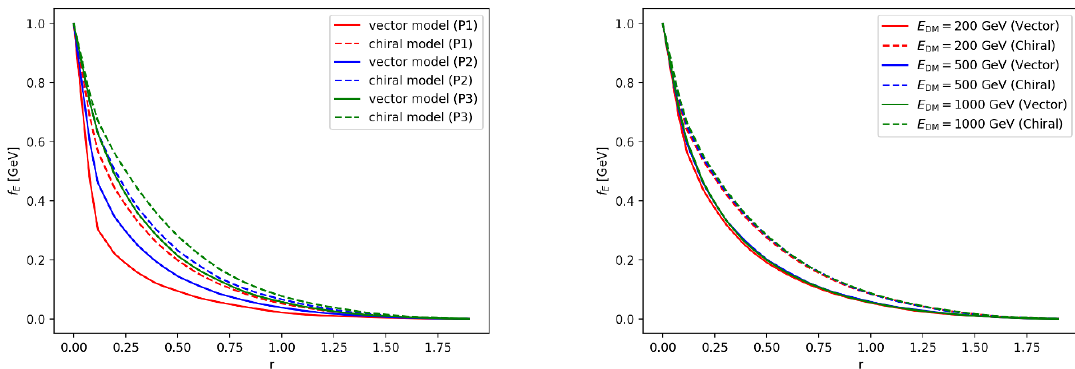
Figure 7 . Left panel: energy pro(cid:12)les of DM jets for three benchmark points in the mono-jet channel ( p T ( j ) > 200 GeV) at 14 TeV LHC. Right panel: energy pro(cid:12)les of DM jets for Point A with di(cid:11)erent DM